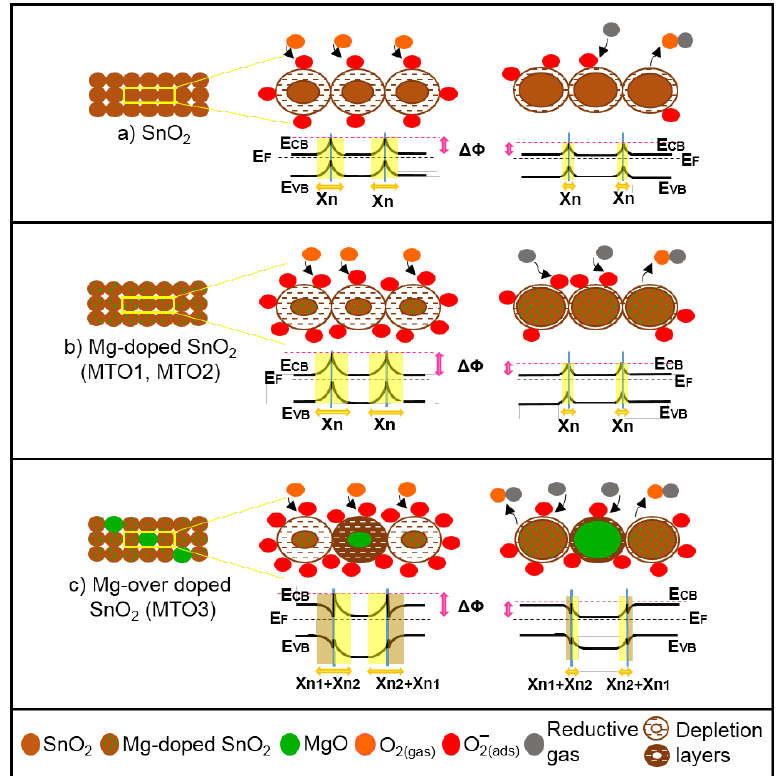
Figure 13. Schematic representation of the gas sensing mechanisms of ( a ) non-doped and ( b and c ) Mg-doped SnO 2 films in air (left) and reductive gas (right). E CB is the bottom of conduction band; E F is the bulk Fermi level; E VB is the top of valence band; ΔΦ is the built-in potential barrier; Χn , and Χn 2 are depth of the depletion layer from the surface; Χn 1 is the depth of the accumulation layer from the surface (not to scale).